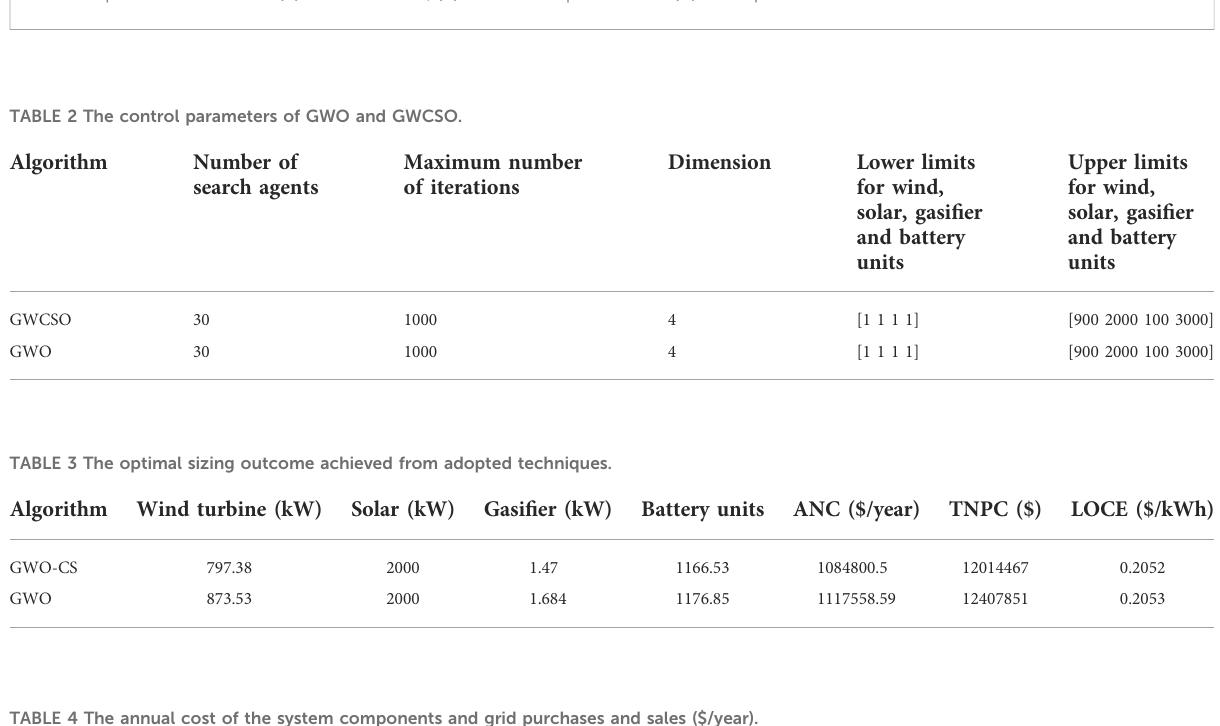
TABLE 4 The annual cost of the system components and grid purchases and sales